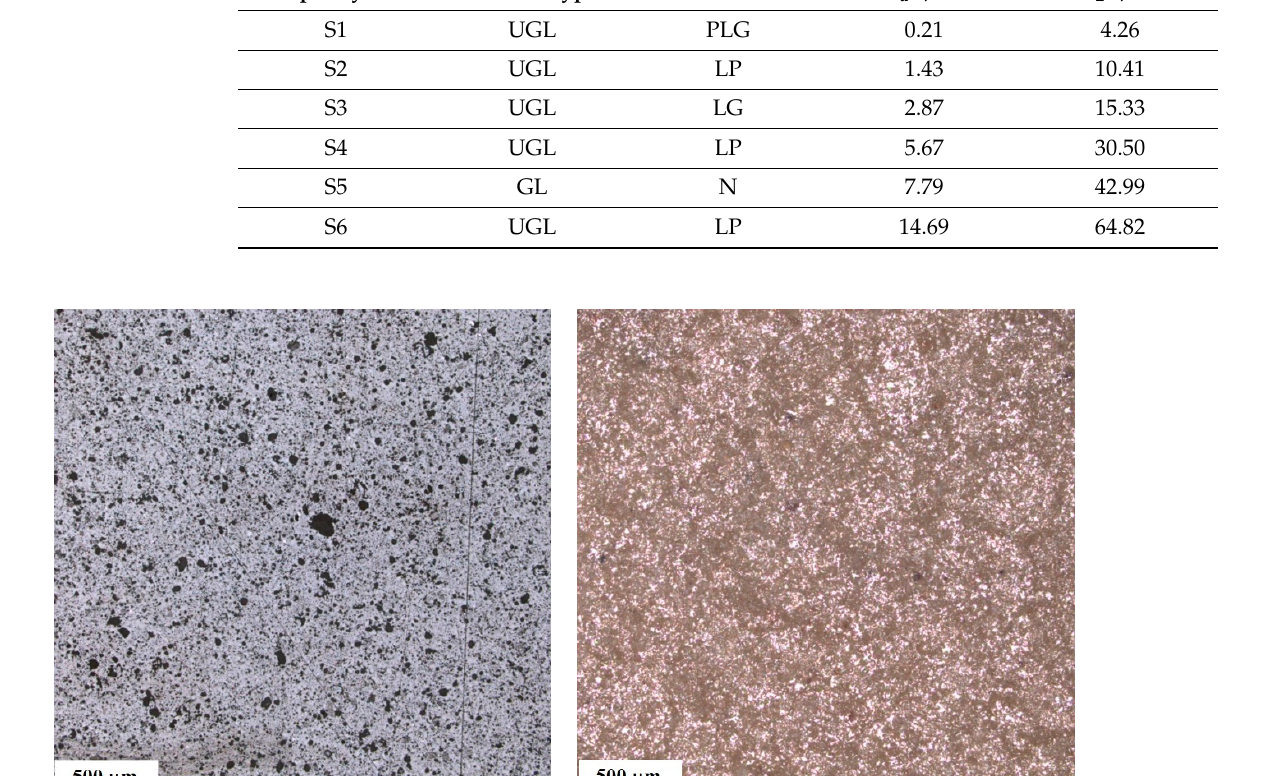
Table 1. The properties of tested ceramic tiles.